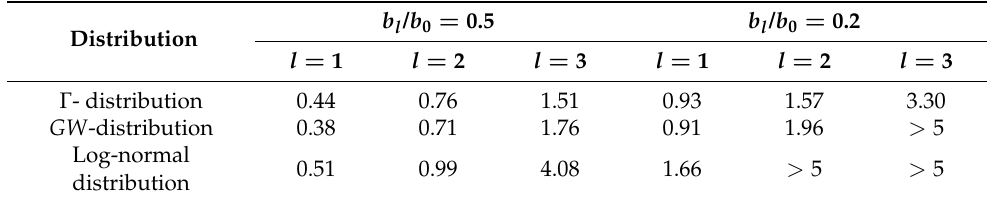
Table 1. Boundary values for the coefficient of variation c ∗ for 4-out-of-6 : F system.